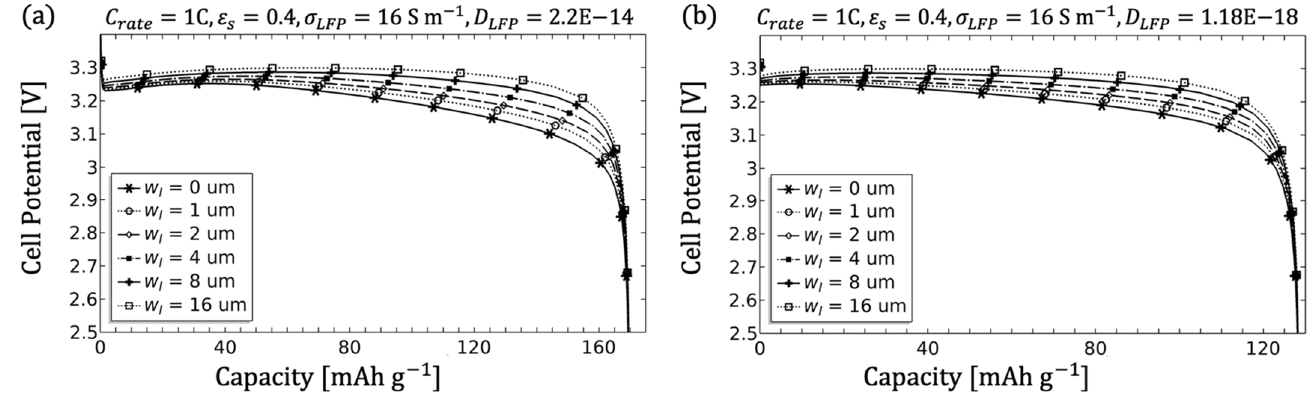
Figure 12. Changing the tortuosity by building a macrostructure that creates a transport channel with an adjustable width w l and τ = 1. The discharge performances are shown in ( a ) with D LFP = 2.2 × 10 − 14 at 1C with an optimised ε s = 0.4 and (cid:2026) (cid:3013)(cid:3007)(cid:3017) = 16 S m − 1 and in ( b ) with (cid:1830) (cid:3013)(cid:3007)(cid:3017) = 1.18 × 10 (cid:2879)(cid:2869)(cid:2876) .